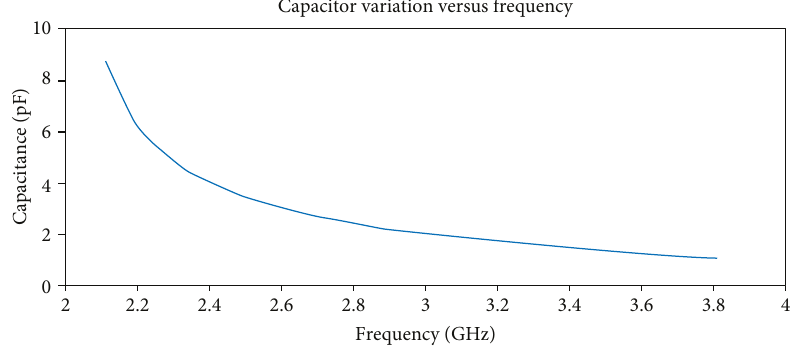
Figure 12: Variation of the varactor capacitance over frequency